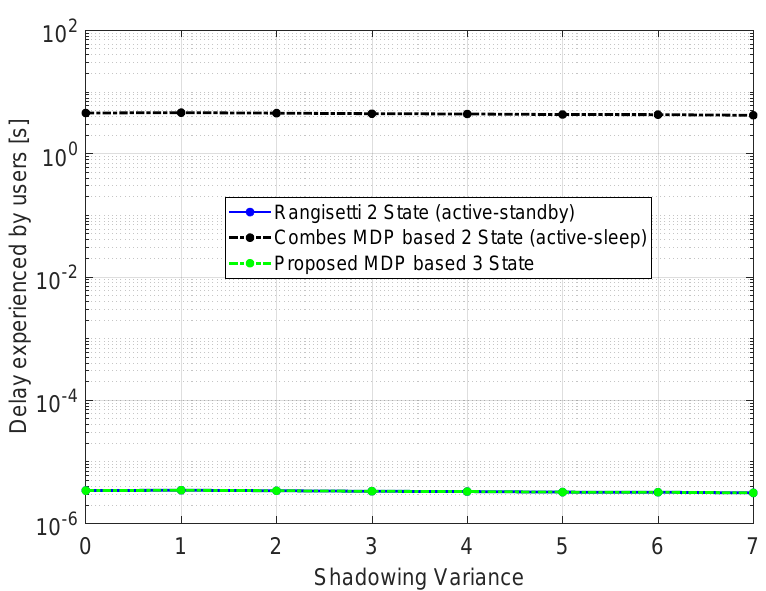
Figure 11. Effect of varying variance of shadowing.